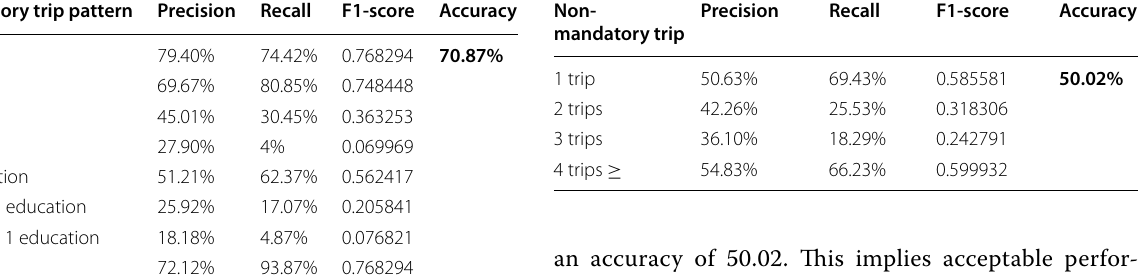
Table 5 The evaluation metrics of mandatory trips pattern generation Mandatory trip pattern Precision Recall